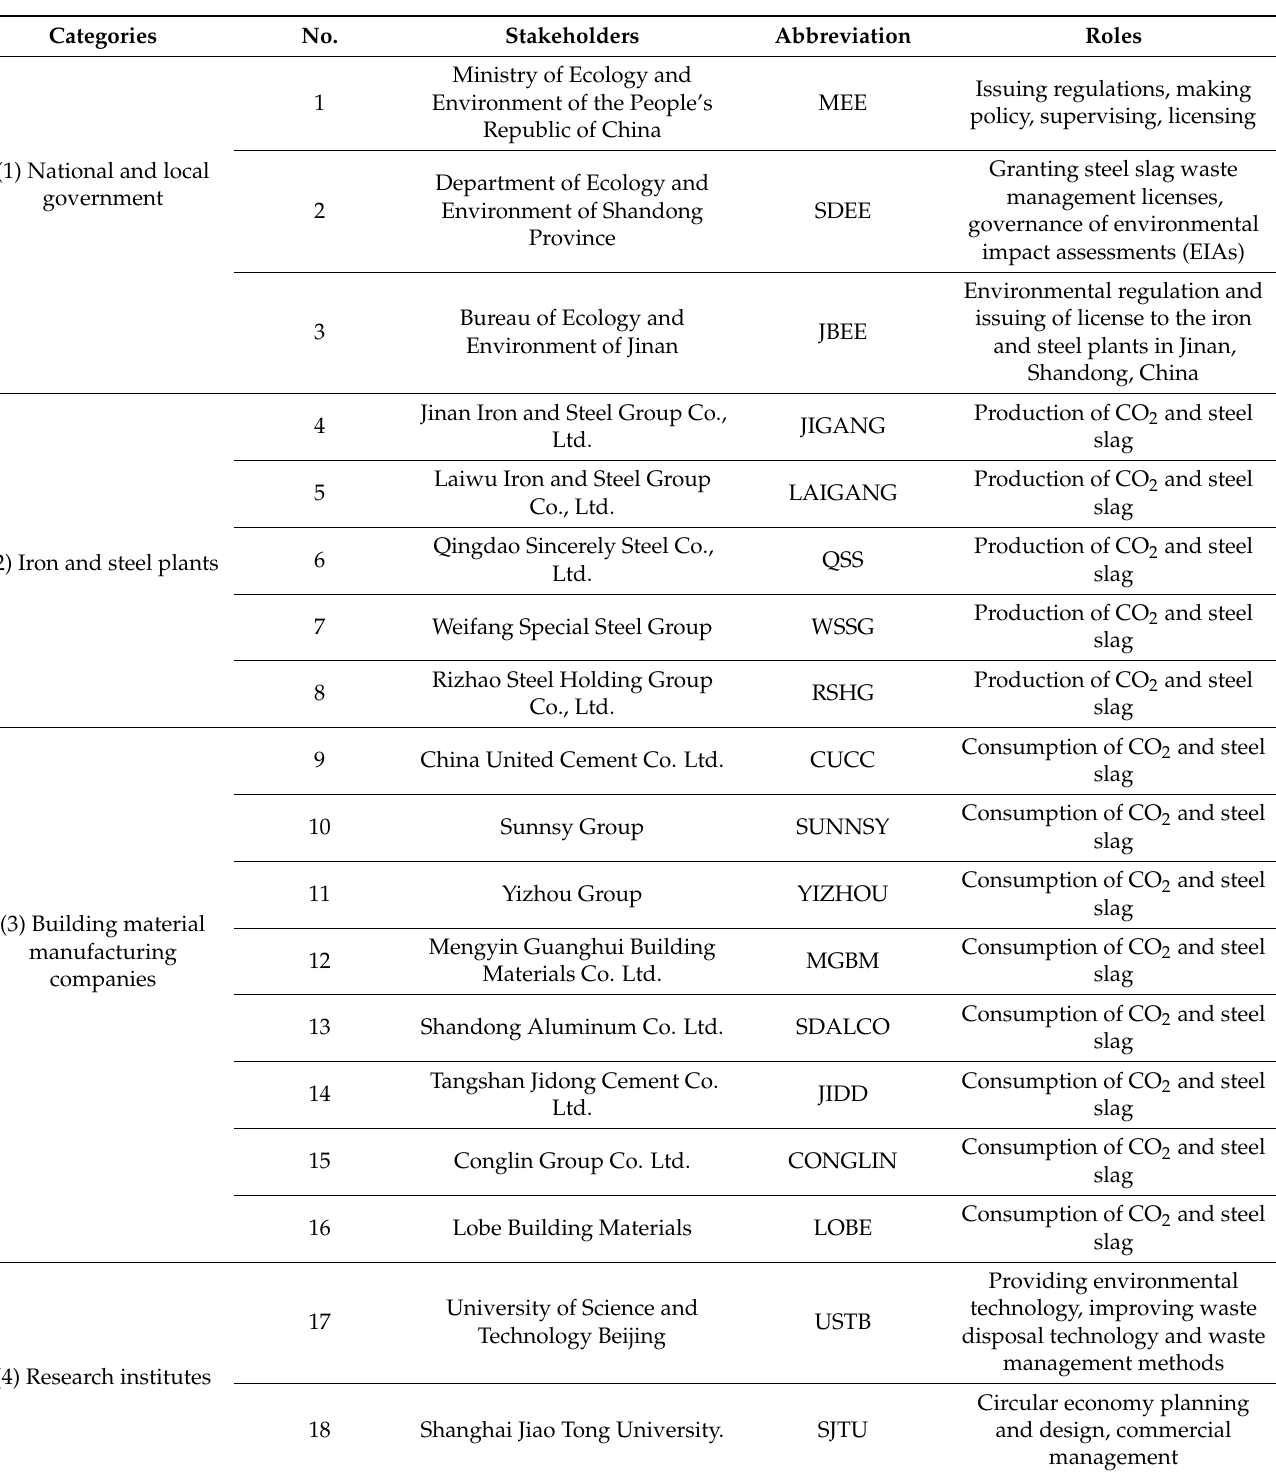
Table 4. Stakeholder and instruction table for the practical implementation of carbonation curing on steel